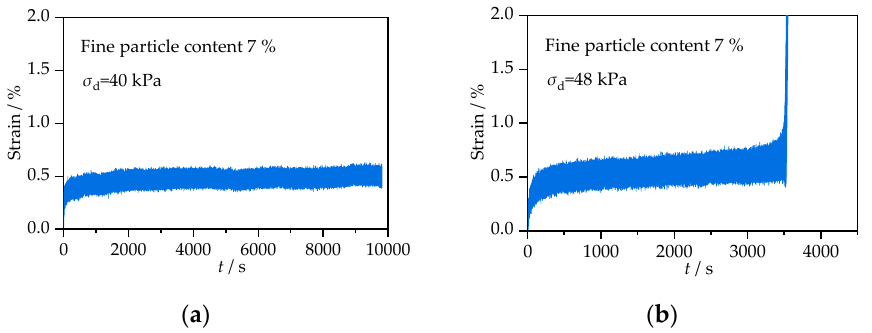
Figure 4. Accumulated strain of the saturated silt with 7% fine particle content. ( a ) σ d = 40 kPa (Stable mode); ( b ) σ d = 48 kPa (Failure mode).